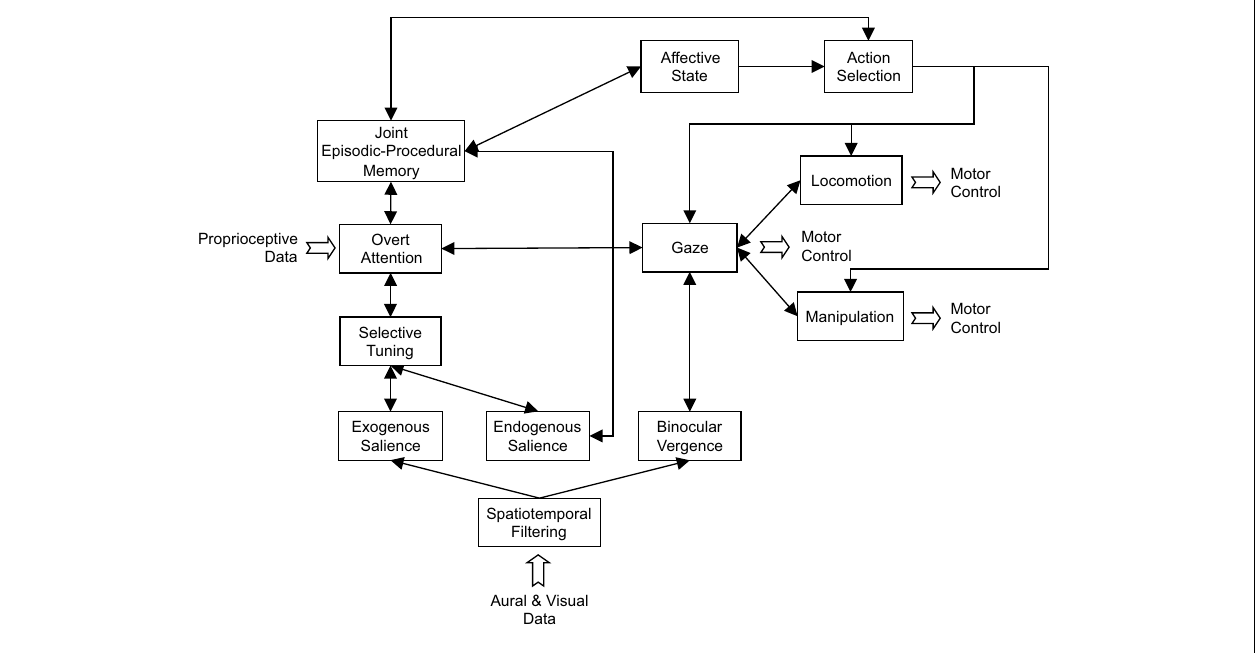
FIGURE 11 | A variant of the iCub cognitive architecture (Vernon et al., 2007, 2010) targeting visual attention with information-theoretic